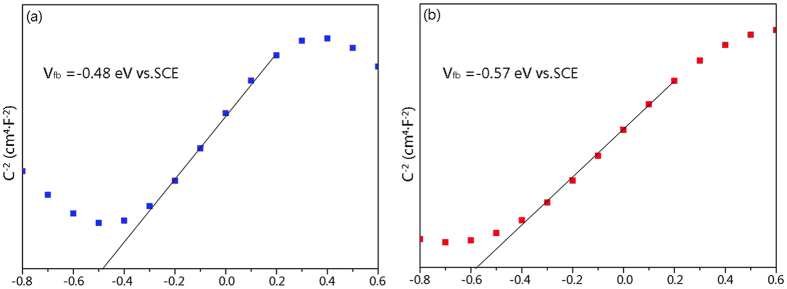
Mott-Schottky plots of (a) the pure TiO2-treated wood and (b) the TiO2/Cu2O-treated wood.